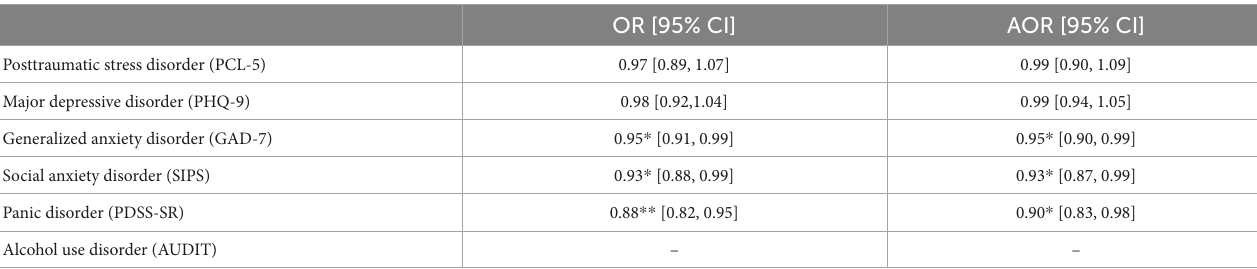
TABLE 2 Relationship between social support scores and positive screens for mental health